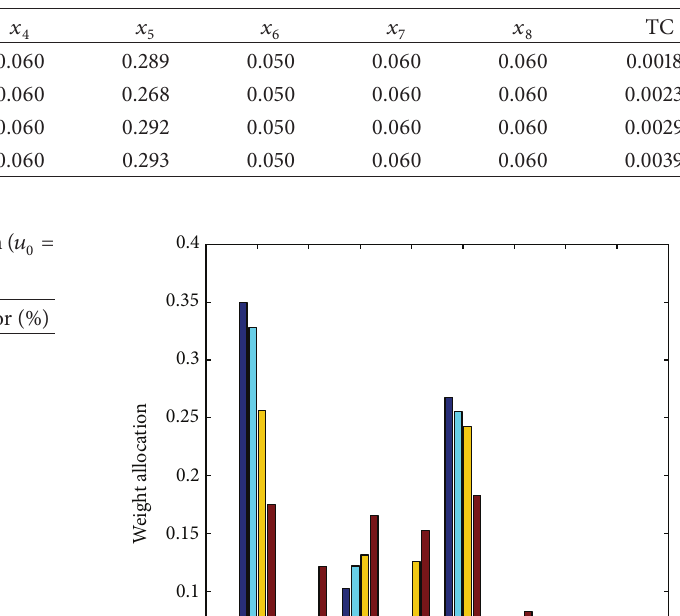
Table 3: The efficient portfolios under different transaction costs ( 𝜇 0 = 0.08 , ℎ 0 = 1.7 ).